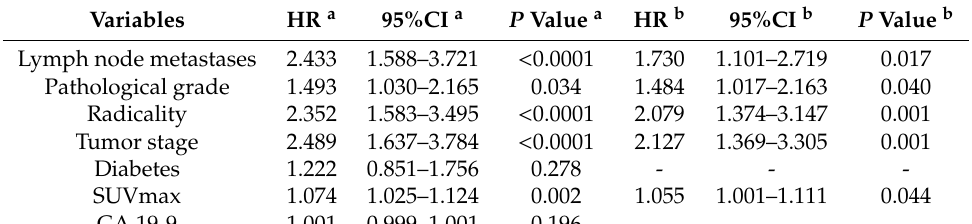
Table 3. Association Between Preoperative Variables and Overall Survival on Univariate a and Multivariate b Cox Regression Model.